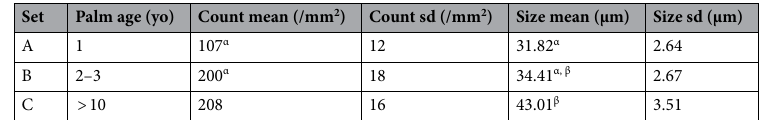
Table 2. Stomatal count and size across different palm age groups. The stomatal counts and standard deviations (sd) were rounded to its’ nearest integer. Significant differences at p-value < 0.05 were represented as α for A versus B, and β for B versus C.